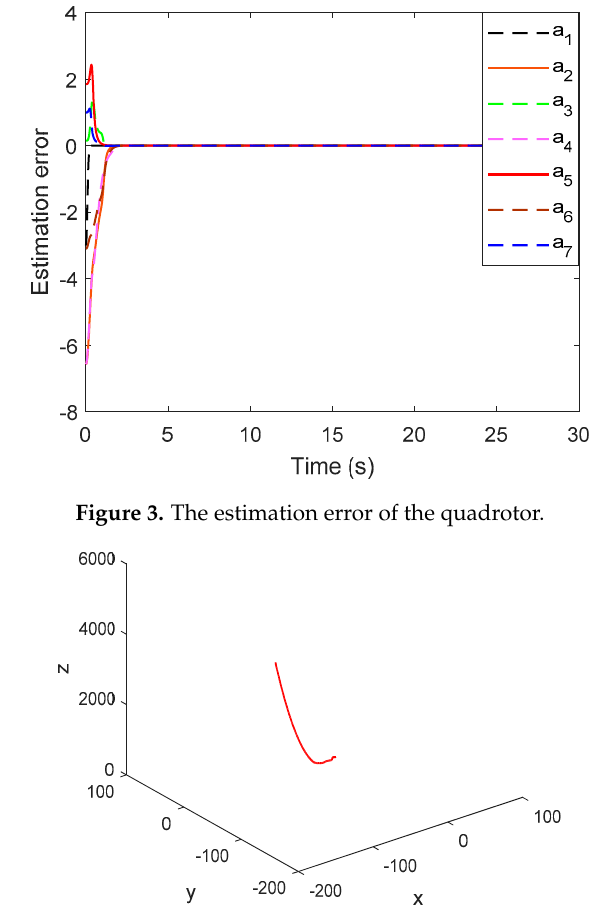
Figure 4. The flight trajectory of the quadrotor (mm).